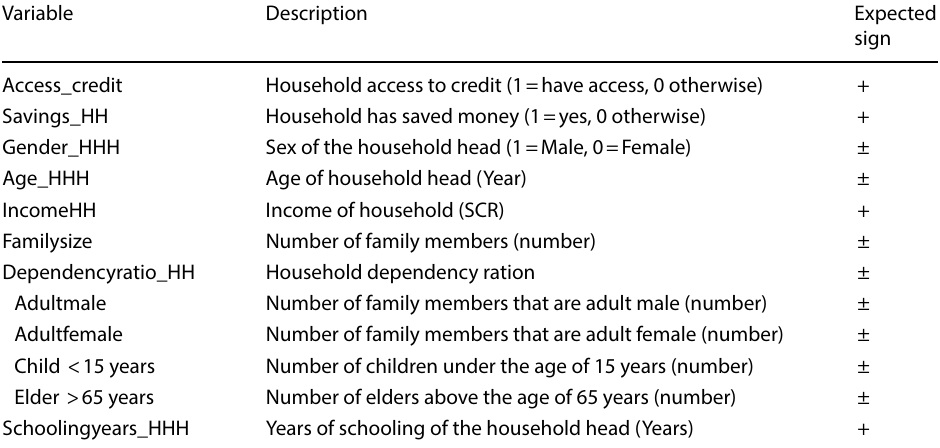
Table 1 Explanatory variables and their likely influence on household adoption of solar PV